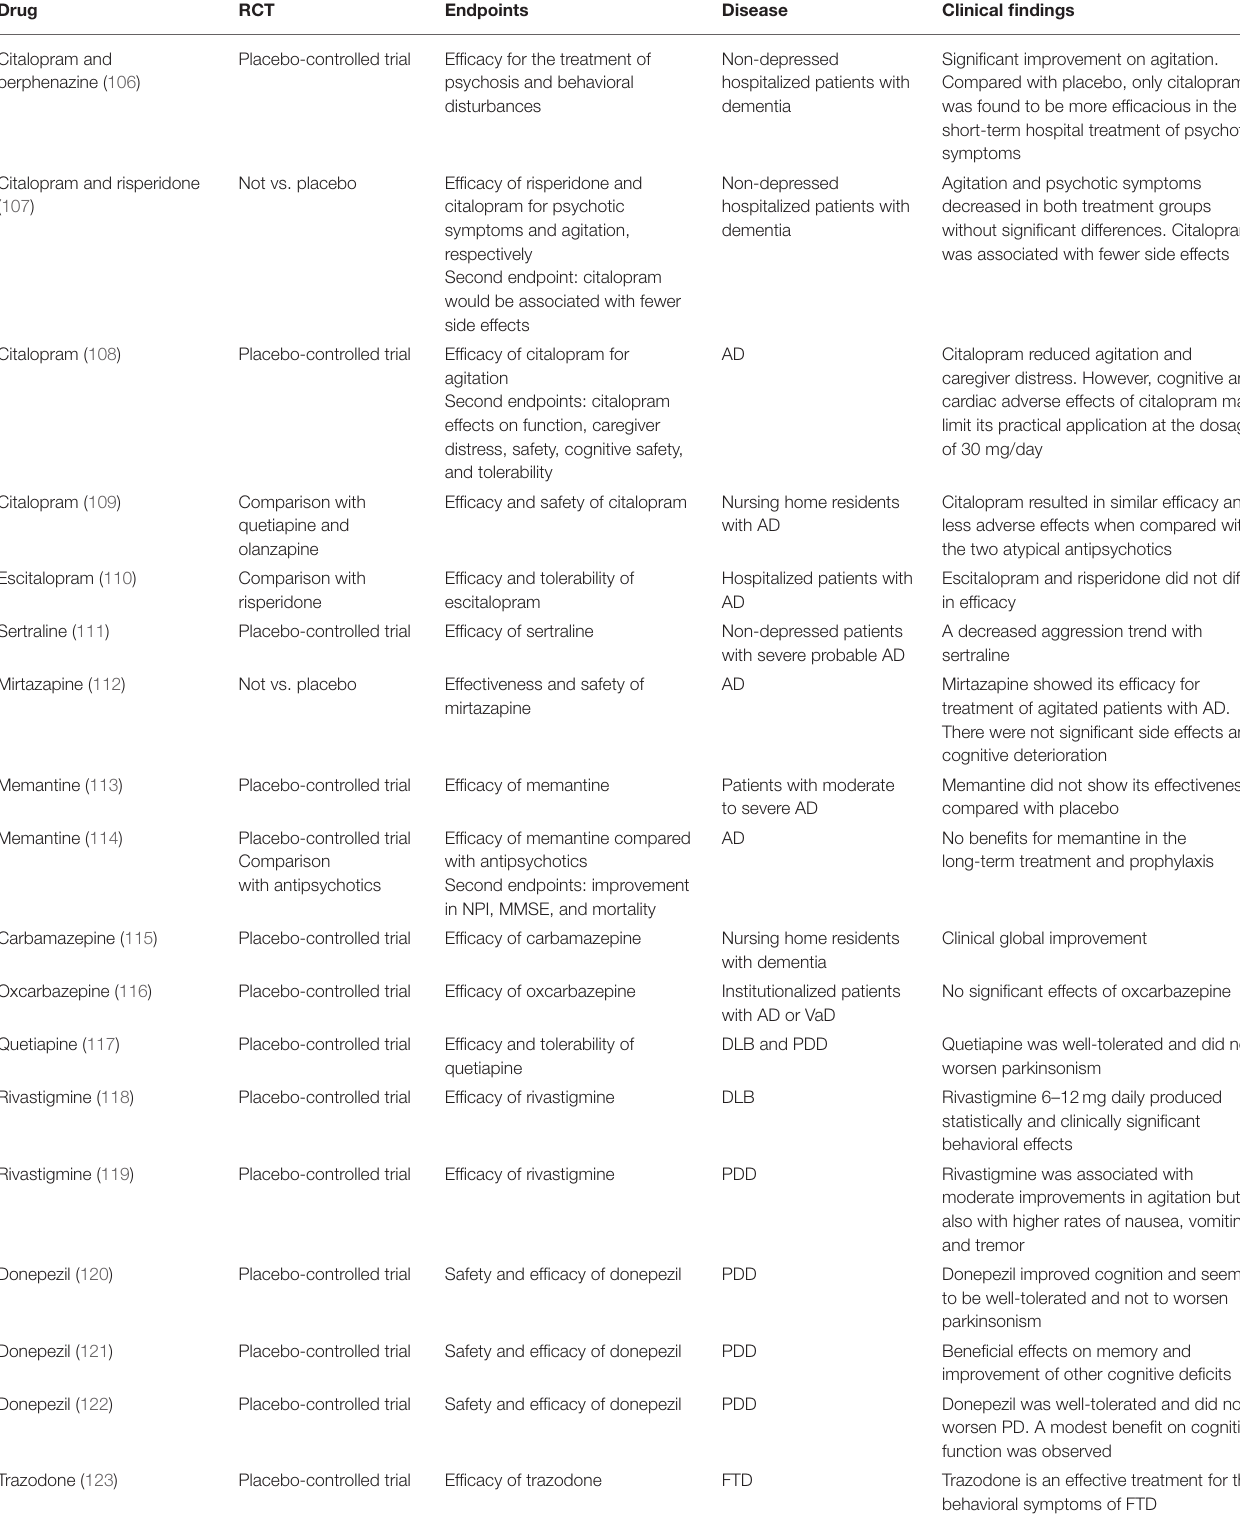
TABLE 2 | Summary of randomized, controlled trials (RCTs) for agitation in